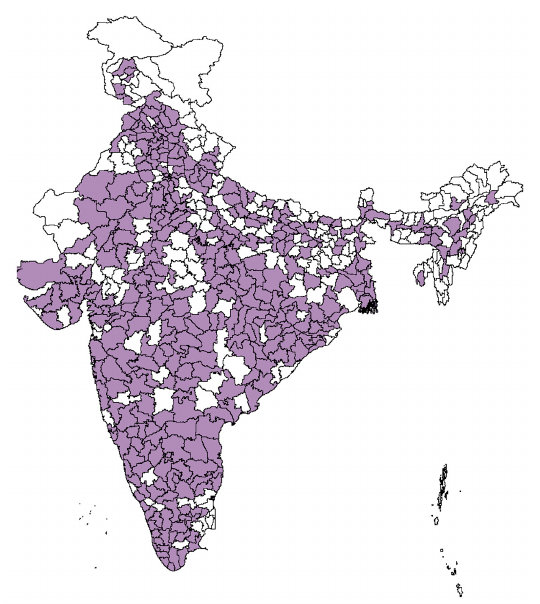
Figure 5. Communities surveyed in the Indian Human Development Survey (IHDS) (all districts surveyed during the first wave of the IHDS). Source: Indian Human Development Survey (IHDS).